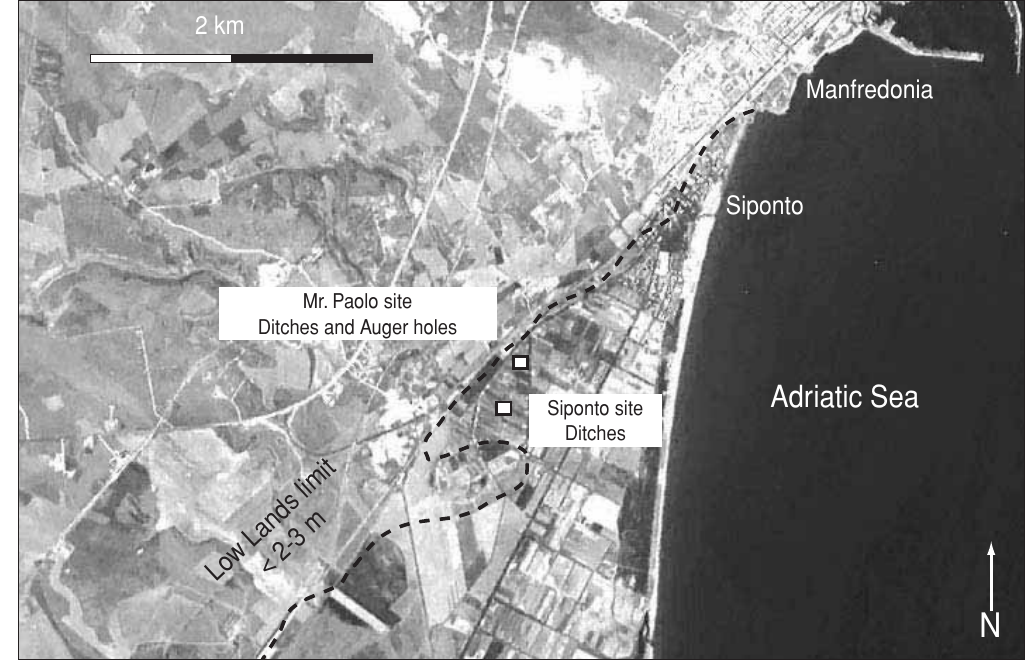
Fig. 10. Spot image (DOI-10M - National Imagery and Mapping Agency: contains data (C) CNES/SPOT image 1992-1994 copyright) of the Siponto area with the sites investigated in the present work. The dashed black line encircles the low lands that could probably be inundated by tsunami